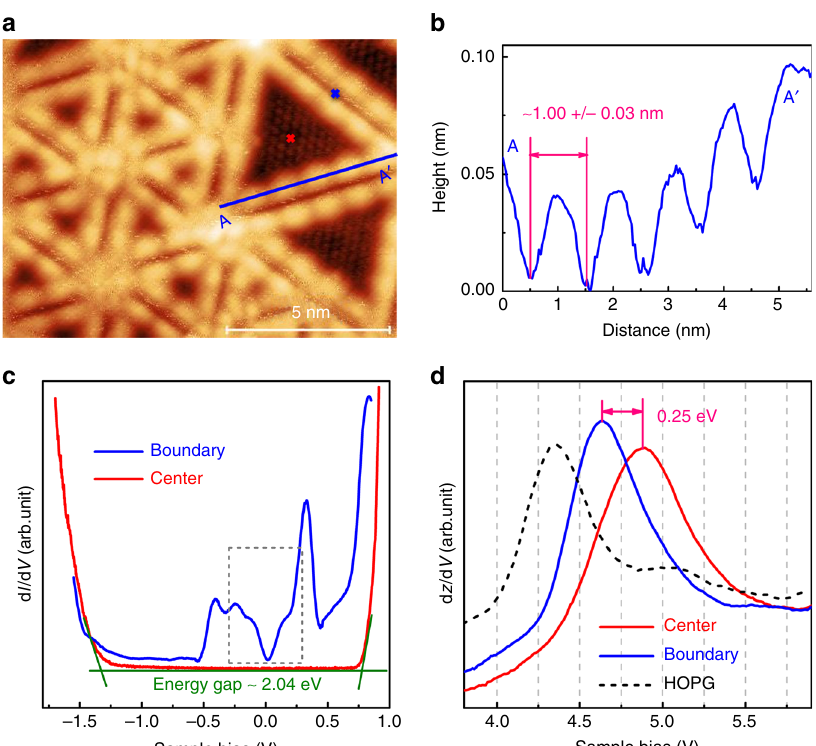
Fig. 2 The electronic properties of the MoSe 2 fi lm. a Atomically-resolved STM image of the ML-MoSe 2 surface shows the periodic intensity undulations in MTBs ( V S = -900 mV and I = 96 pA; size: 12 × 9 nm 2 ). b The line pro fi le along the blue line AA ’ in fi gure ( a ). c d I/ d V spectra recorded at the domain centre (red line) and MTB boundary (blue line) reveal their semiconducting and metallic nature. d Field emission resonances (FERs) measured by d z/ d V spectra on HOPG substrate, MTBs and the centre of triangle MoSe 2 domains, respectively. Data were taken at constant tip height ( V S = 1.2 V, I = 60 pA) with a modulation of 25 mV and 963 Hz. The red and blue crosses in panel a mark the locations of the measurements of the spectra shown in c and local work function of the underlying sample. Fig. 2d shows the FER spectra measured at different regions of MoSe 2 as well as the clean HOPG substrate for comparison. On the bare HOPG (black dashed curve), the fi rst FER peak appears at 4.35 ± 0.05 eV, in a good agreement with the work function of HOPG in the range of 4.4 – 4.8 eV 42 . Interestingly, the triangle MoSe 2 domains (red curve) yield their fi rst FER at 4.88 ± 0.05 eV, while the MTB regions (blue curve) fi rst resonate at 4.63 ± 0.05 eV, indicating a shift of ~0.25 eV towards lower energy compared to that of the adjacent pristine triangle domain.